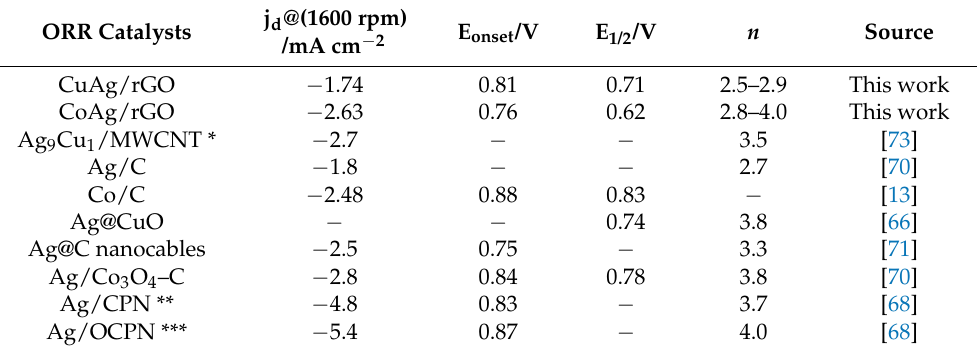
Table 1. Comparison of ORR parameters of CuAg/rGO and CoAg/rGO electrocatalysts with the activity of similar materials reported in the literature.